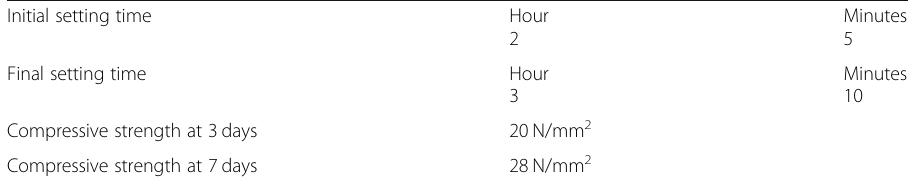
Table 3 Main physical and mechanical properties of the used ordinary Portland cement (CEM I) complying with ESS